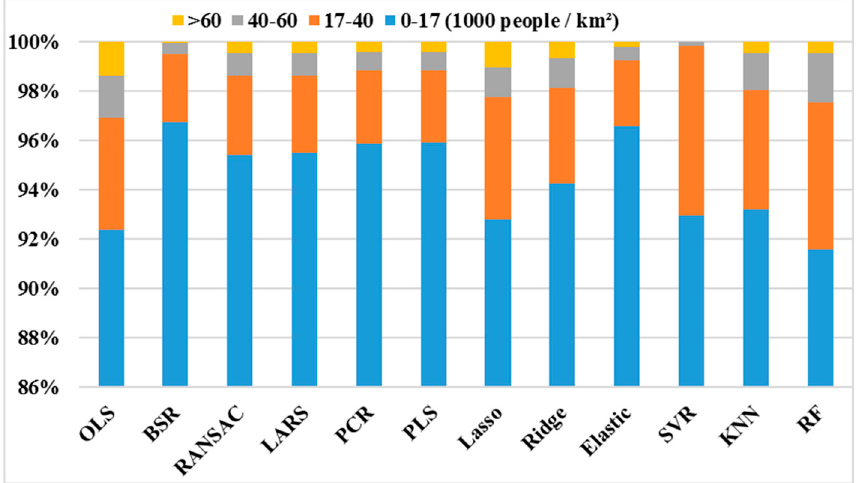
Figure 4. Grouping statistics for the proportion of cells with different population densities.